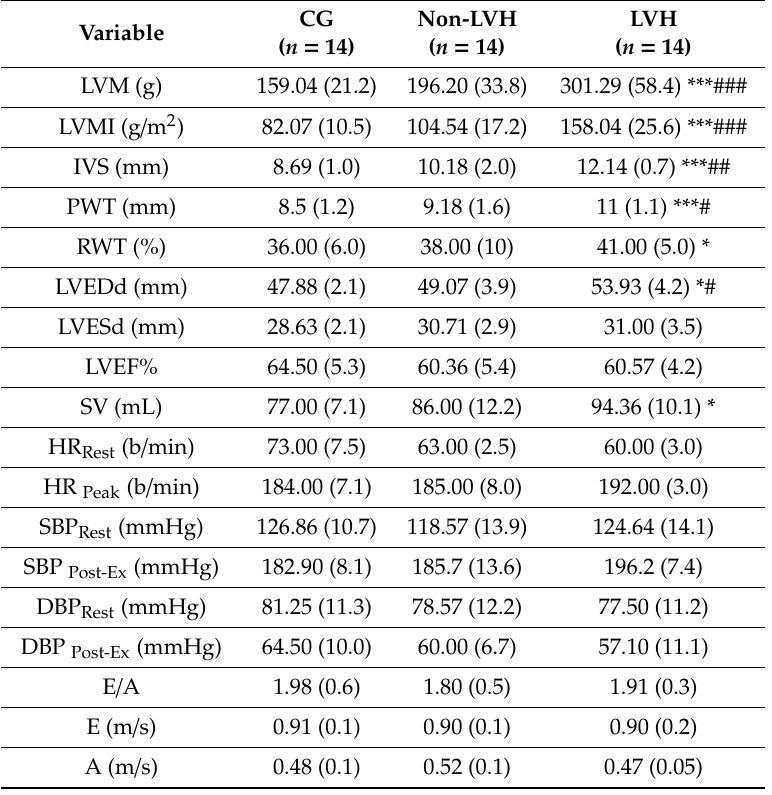
Table 2. Echocardiographic variables and blood pressure in athletes with left ventricle hypertrophy (LVH), athletes without left ventricle hypertrophy (non-LVH), and untrained control group